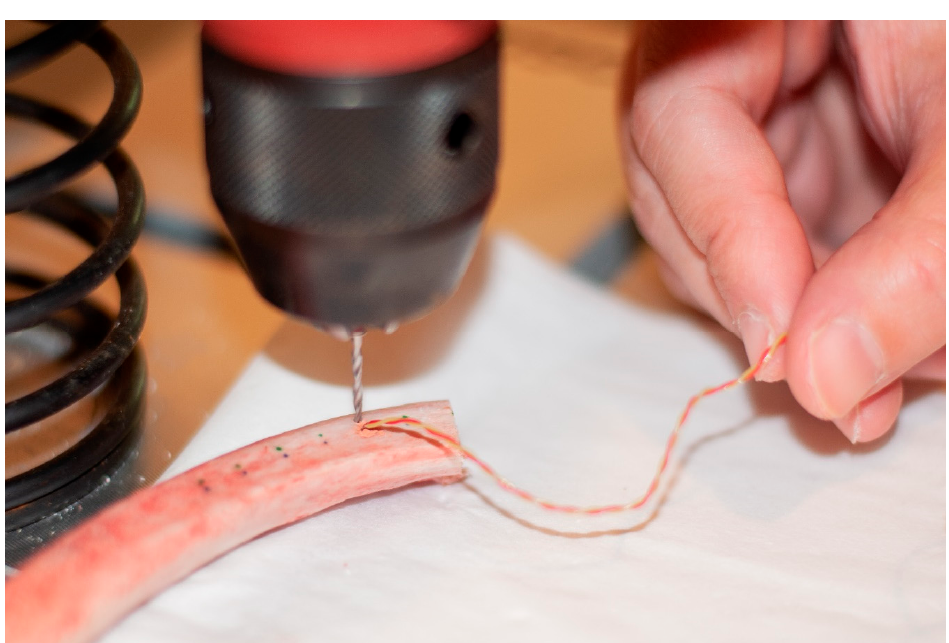
Figure 3. A close-up of the experimental setting.